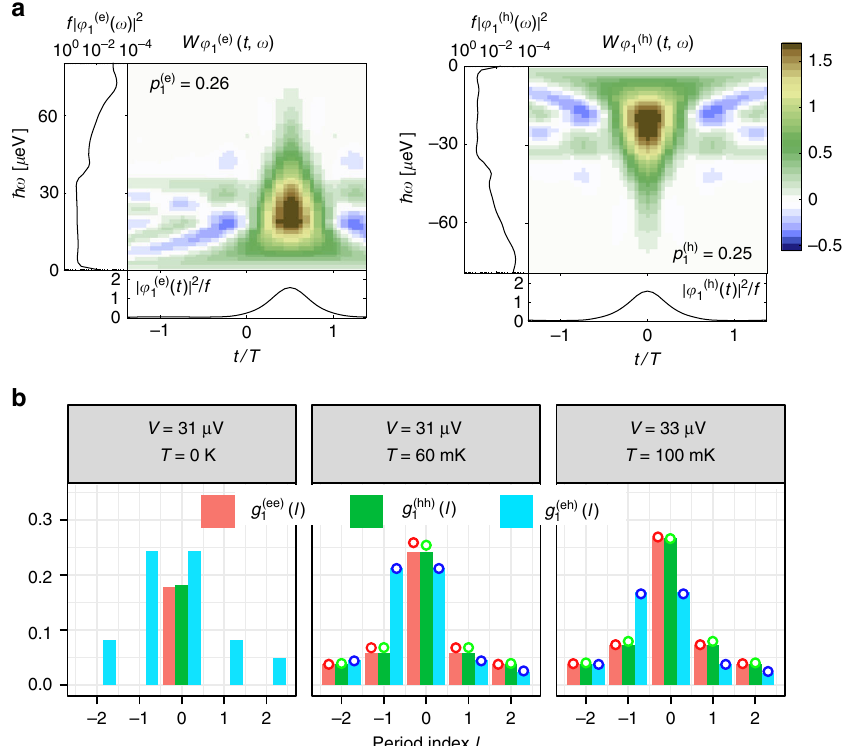
ð t ; ω Þ ¼ φ ð e = h Þ 1 = 100 el ð t Þj 2 = f and energy f j φ ð e = h Þ ð ω Þj 2 distributions obtained by 1 1